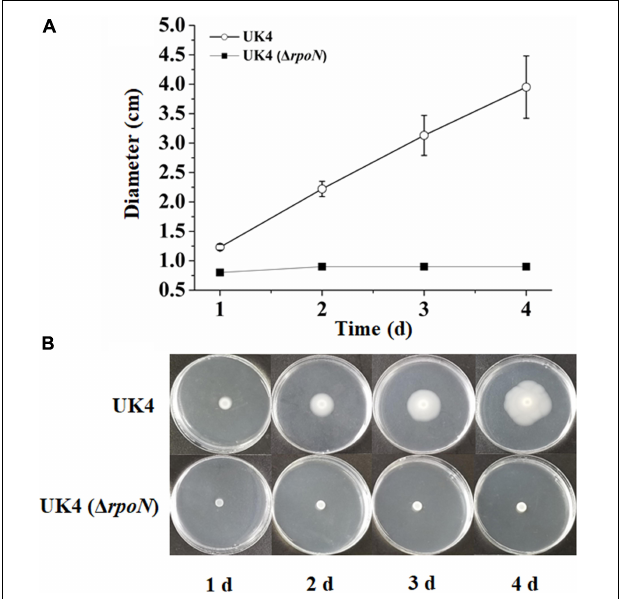
FIGURE 1 | Swimming motility of P . fluorescens wild-type strain UK4 and the mutant strain (cid:49) rpoN . (A) Swimming diameter of UK4 and (cid:49) rpoN . Data are expressed as mean ± SD of six independent experiments. (B) Swimming of UK4 and (cid:49) rpoN on swimming-agar plates for 4